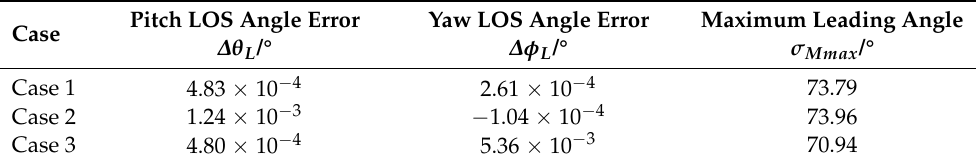
Figure 8. 3-D trajectories of terminal guidance against constant maneuvering targets. Table 1. Terminal guidance performance for attacking constant maneuvering